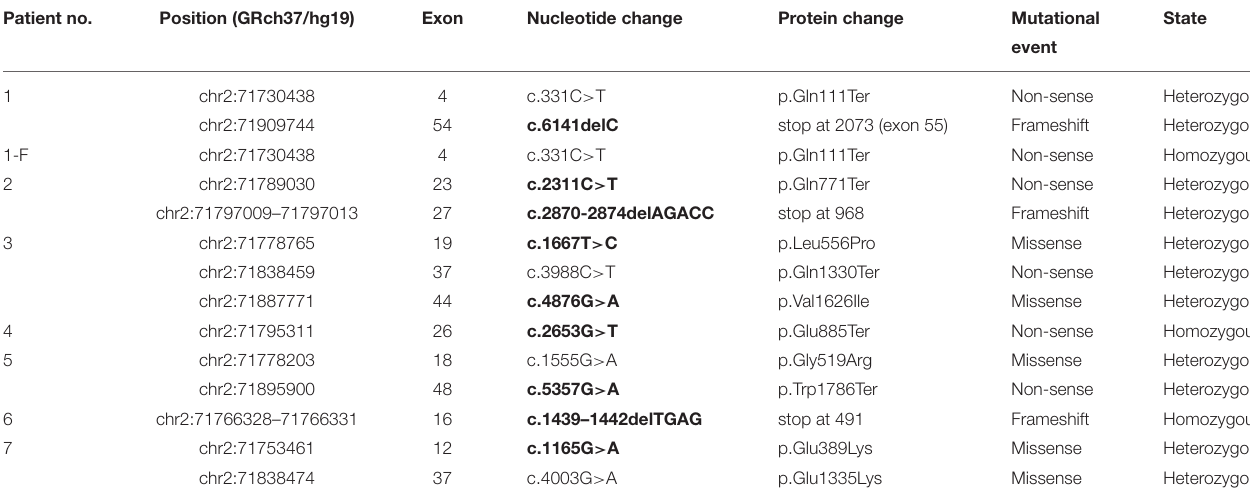
The novel mutations are indicated in bold.